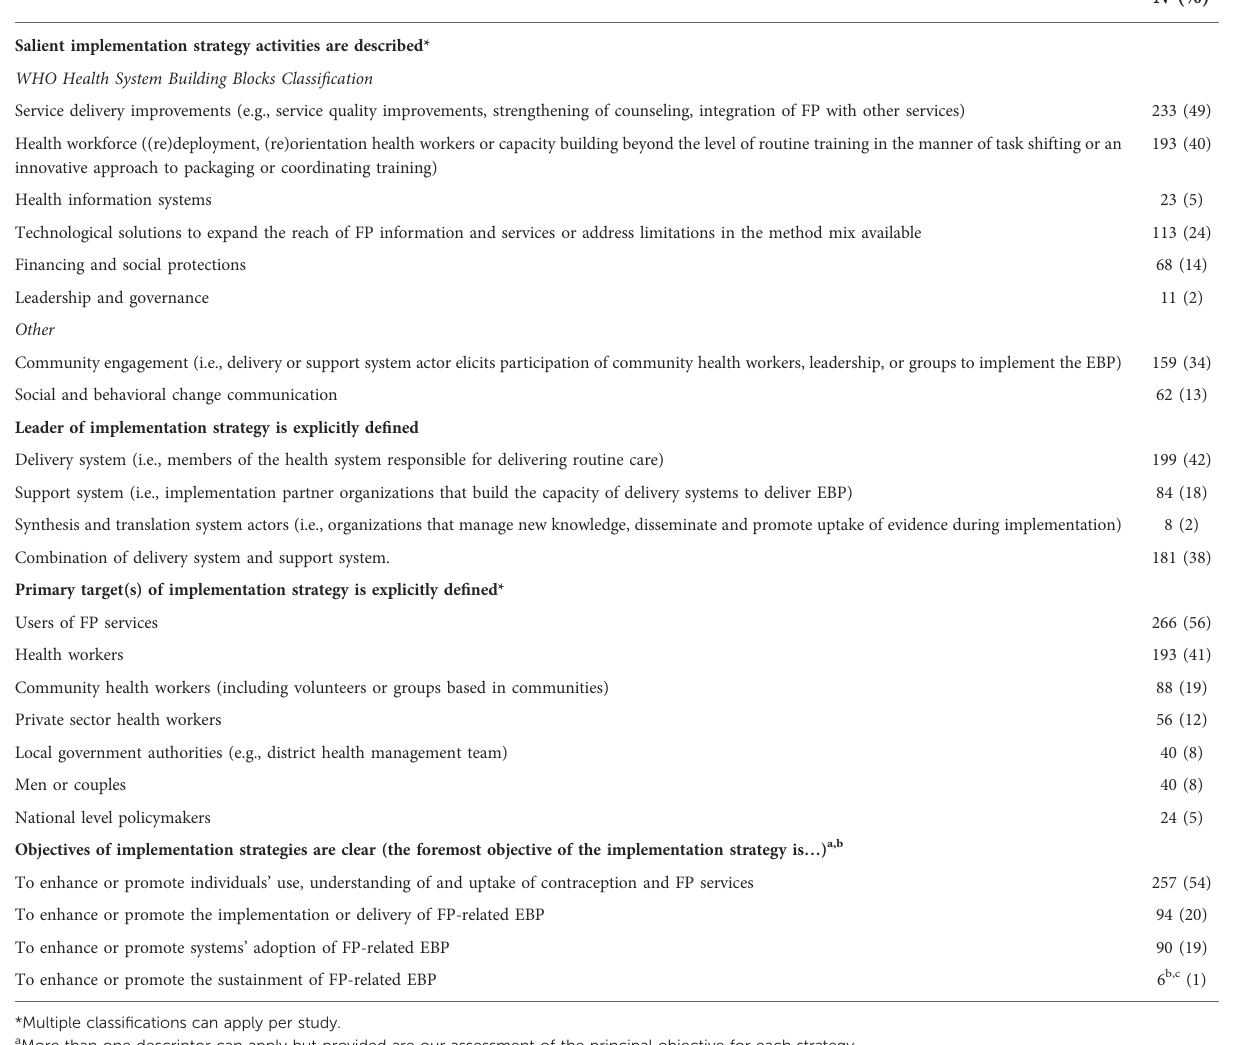
TABLE 1 Speci fi cation of implementation strategies — prevalence of key intervention